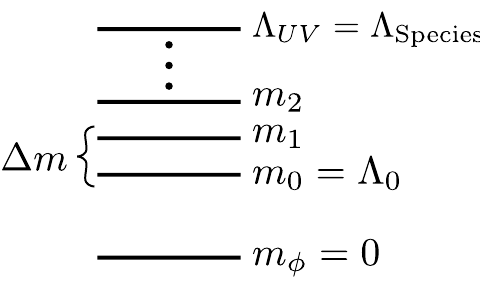
Figure 3 . E(cid:11)ective theory of one light scalar (cid:12)eld (cid:30) and S heavy ones h i up to (cid:3) UV . and so we keep the kinetic term for (cid:30) as unspeci(cid:12)ed at this point. We now integrate out at one loop the heavy scalars. If P S